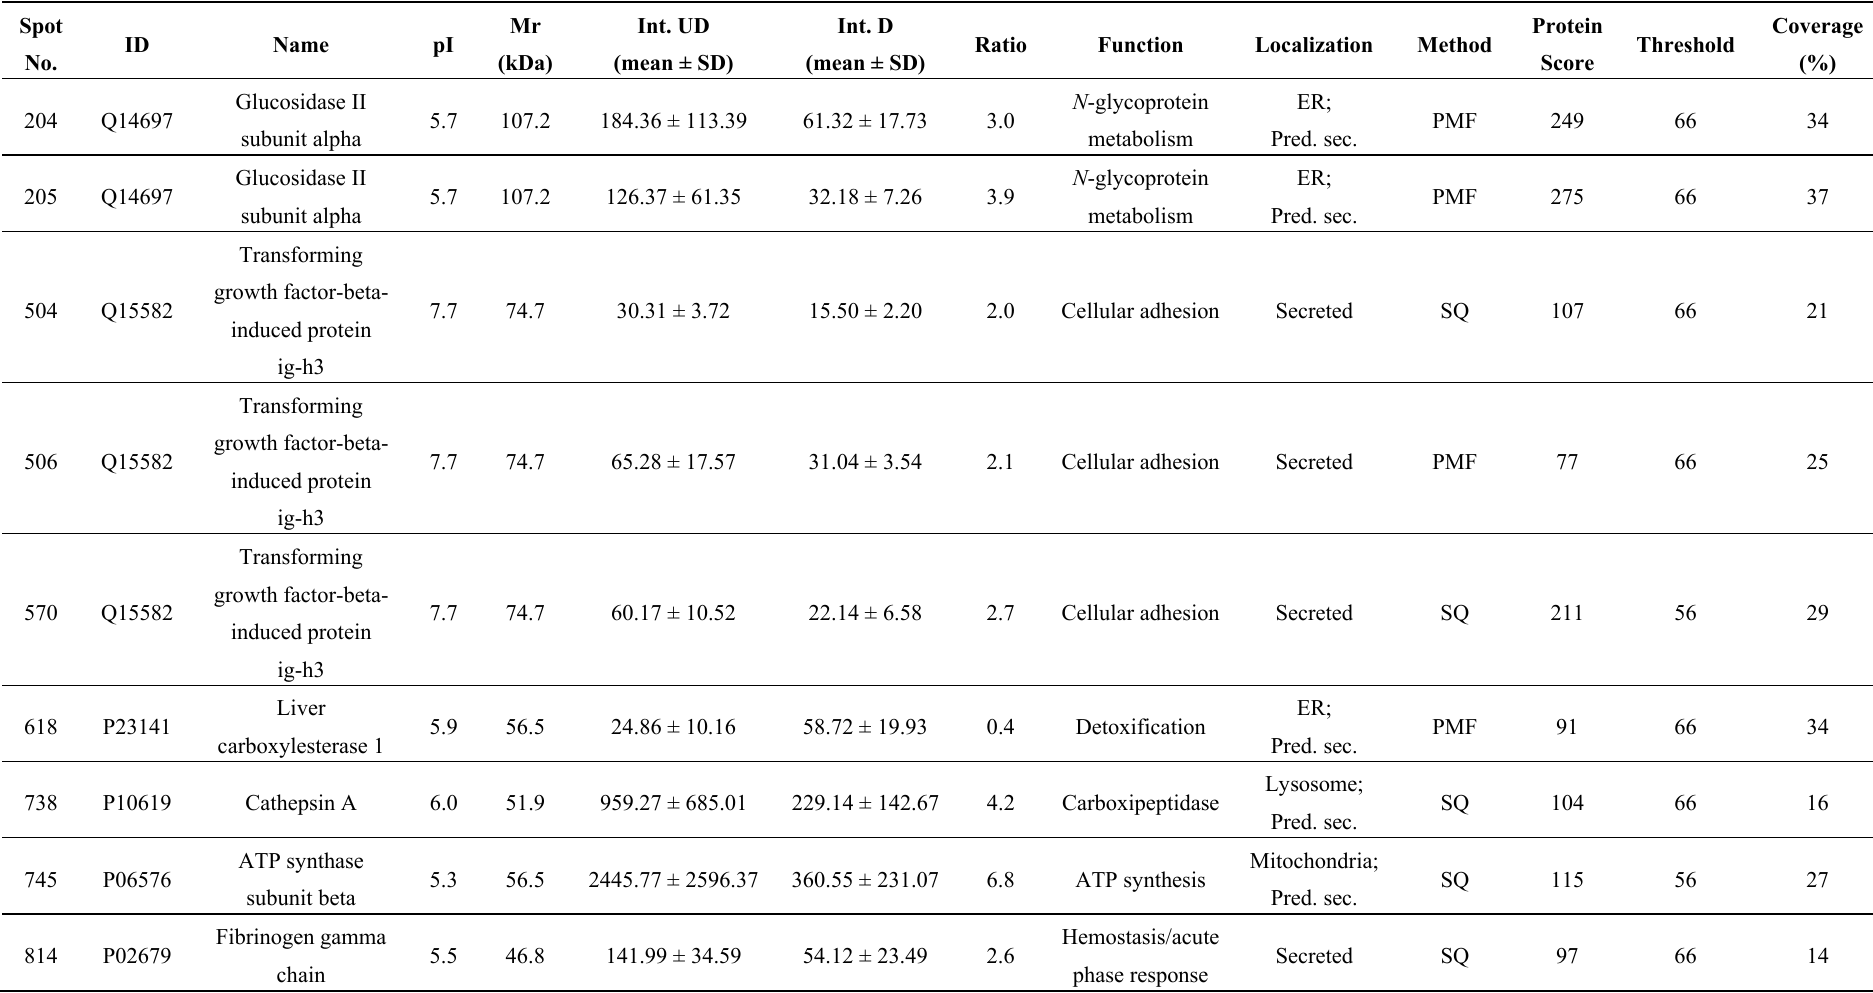
Table 2. Proteins that showed a significant variation in the Caco-2 secretome associated with the differentiation process.